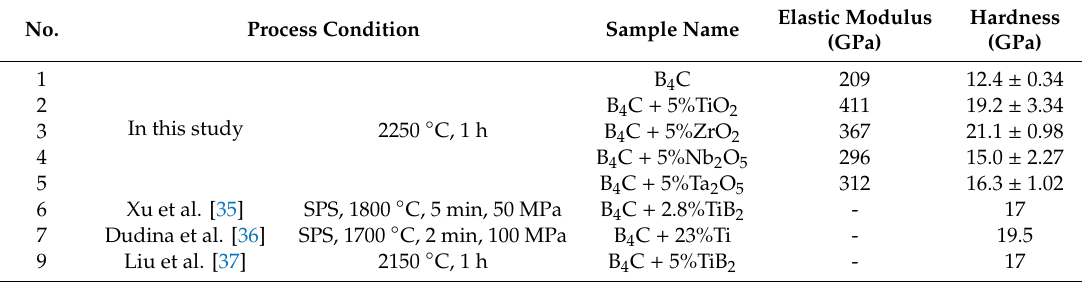
Figure 3. The magnification images of SEM analysis of B 4 C-MeB 2 composites prepared from different additives (Me = Ti, Zr, Nb, or Ta): ( a , b ) +TiO 2 with different magnifications; ( c , d ) +ZrO 2 with different magnifications; ( e , f ) +Nb 2 O 5 with different magnifications; ( g , h ) +Ta 2 O 5 with different magnifications. Table 3. Elastic modulus and Vickers hardness values for di ff erent samples as compared with the reported values [35–37].